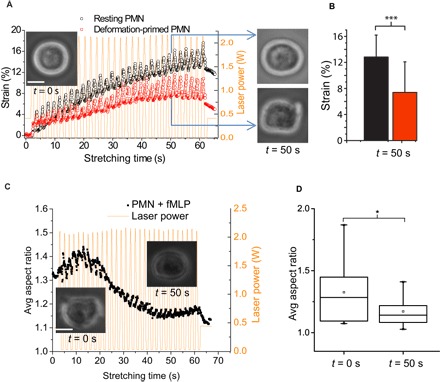
Mechanically induced priming and depolarization of neutrophils.(A) Multiple stretching of round, resting neutrophils in the OS using sinusoidal pulses of laser power (yellow) leads to stiffening of about 40% of the cells (red; n = 11) within 20 to 30 s, acquiring the primed morphology established in Fig. 1 (see inset picture at t = 50 s), compared to still resting cells (black; n = 14). Representative example of n = 3 experiments. (B) Bar graph of average strain of the two groups in (A) at t = 50 s. (C) Repeated sinusoidal pulses of laser power (Pmax = 1 W per fiber; yellow) cause fMLP-primed neutrophils (inset picture of typical cell at t = 0 s) to depolarize, as evidenced by the retraction of pseudopods and decrease in aspect ratio (inset picture, right) (see also movies S2 and S3). The temporal evolution of the average aspect ratio of n = 28 cells, which is typical for n = 4 repeats, is shown. (D) Box plots of the average aspect ratio of fMLP-treated cells in (C) at t = 0 s and t = 50 s. *P < 0.05 and ***P < 0.001 (significant difference). Scale bars, 5 μm.